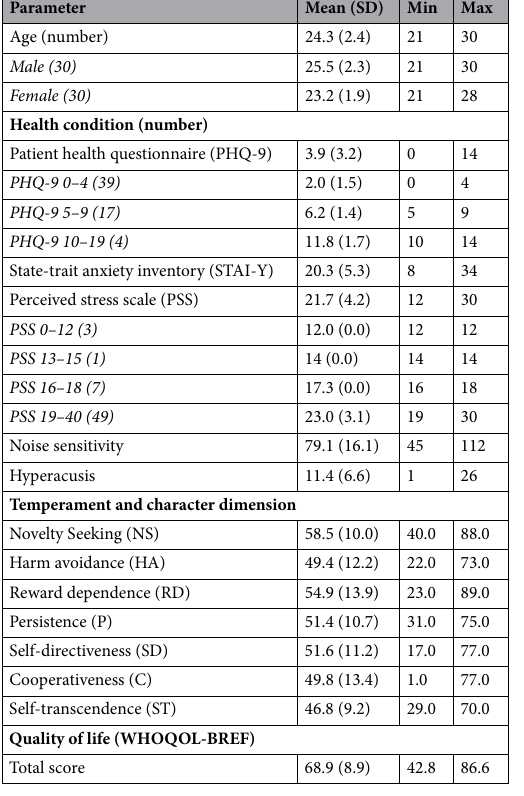
Table 1. Summary of demographical and health conditions of